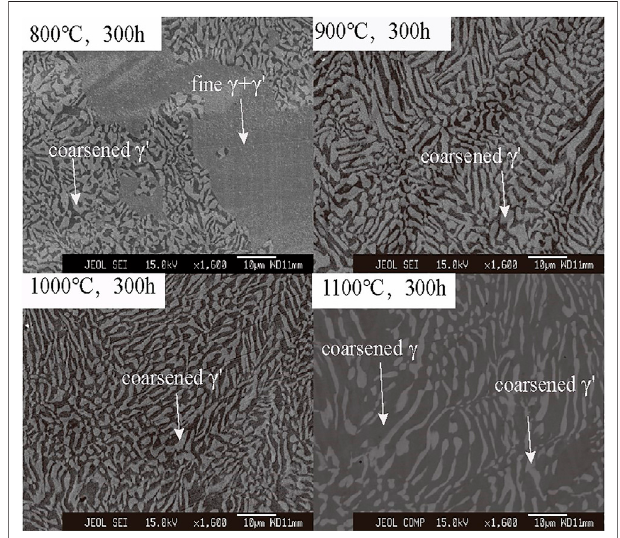
FIGURE 5 | Phase equilibrium microstructure of Co-30Ni-10Al-6Ta (at %) alloy annealed at different temperatures for 300 h after cold-rolling with 50% reduction.